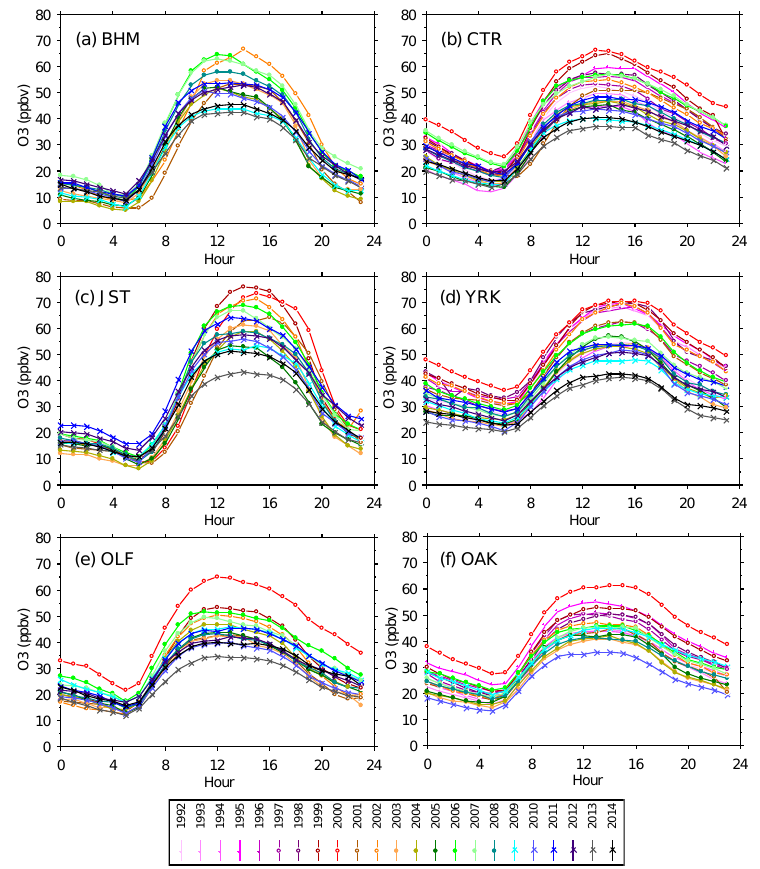
Figure 7. Average O 3 mixing ratios vs. hour, by year. Each data point is the mean of all hourly measurements during June through August. Sites at PNS and GFP (not shown) exhibit similar diurnal profiles and trends (sampling at those sites ended after 2009 and 2012, respectively). Standard errors of the means are 0.3–4ppbv ( ∼ 2% of mean O 3 mixing